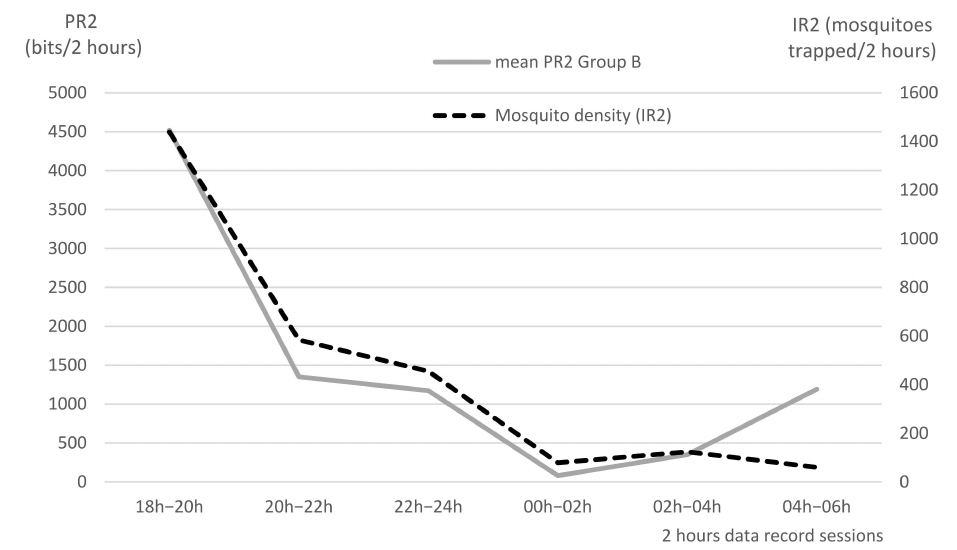
Figure 9. Temporal distribution of mosquitoes trapped (IR2) and pedometer records (PR2) in Group B, for one night (21–22 November 2016) per 2 h data record